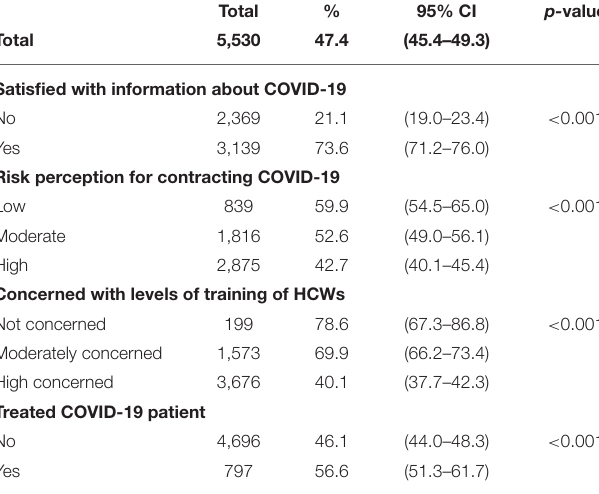
TABLE 2 | Confidence in overall knowledge about COVID-19 by socio-demographic characteristics and knowledge related